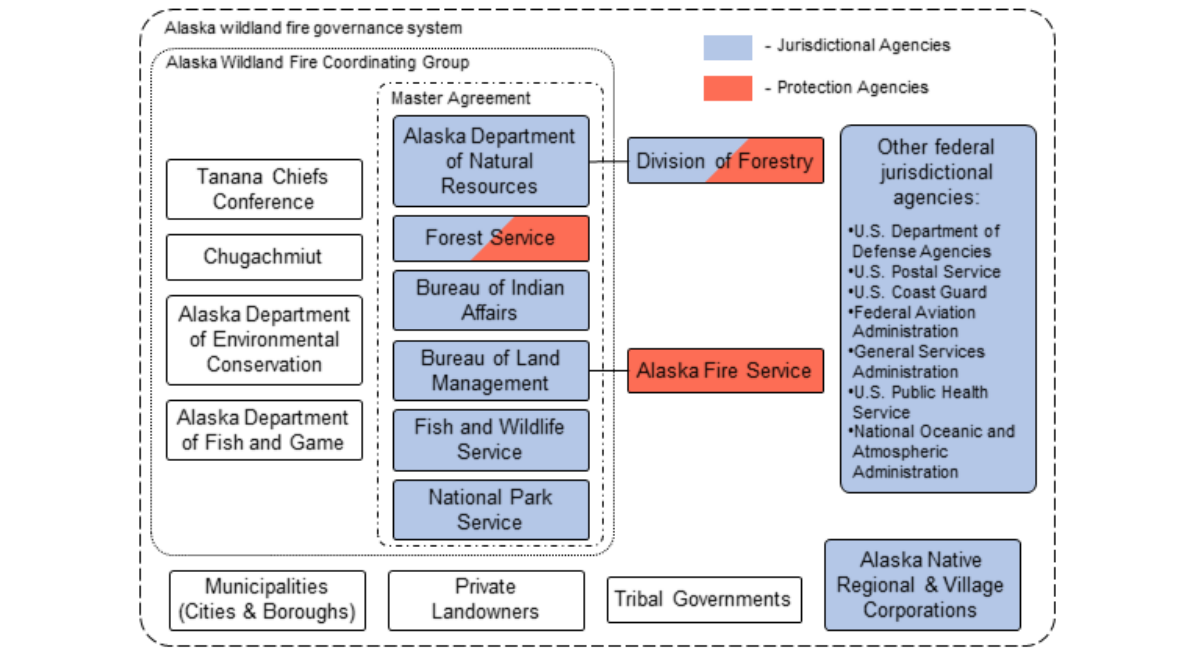
Fig. 2 . Map of Protection Agency Zones. Shaded sections in the map represent areas of suppression responsibility for the U.S.